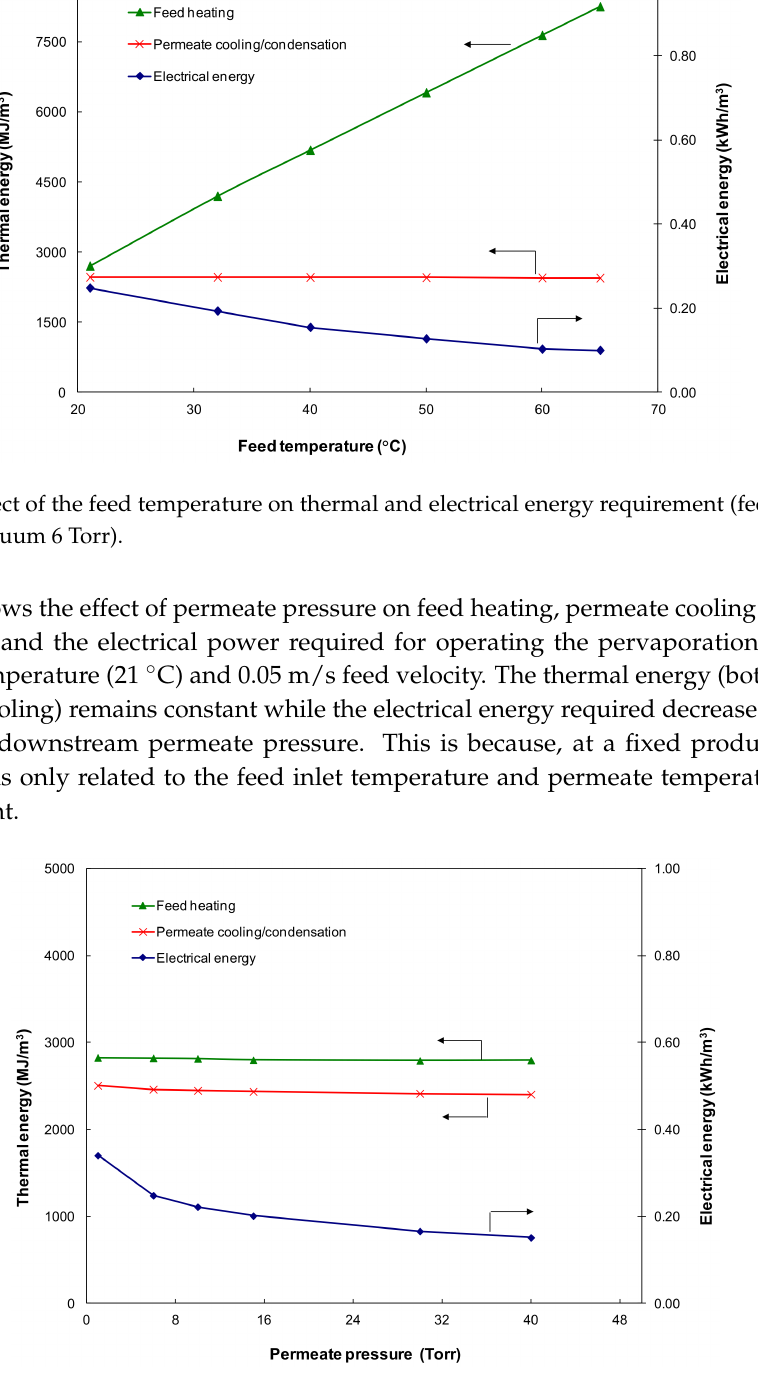
Figure 7. Effect of the permeate pressure on thermal and electrical energy requirement (feed velocity 0.05 m/s, feed temperature 21 ◦